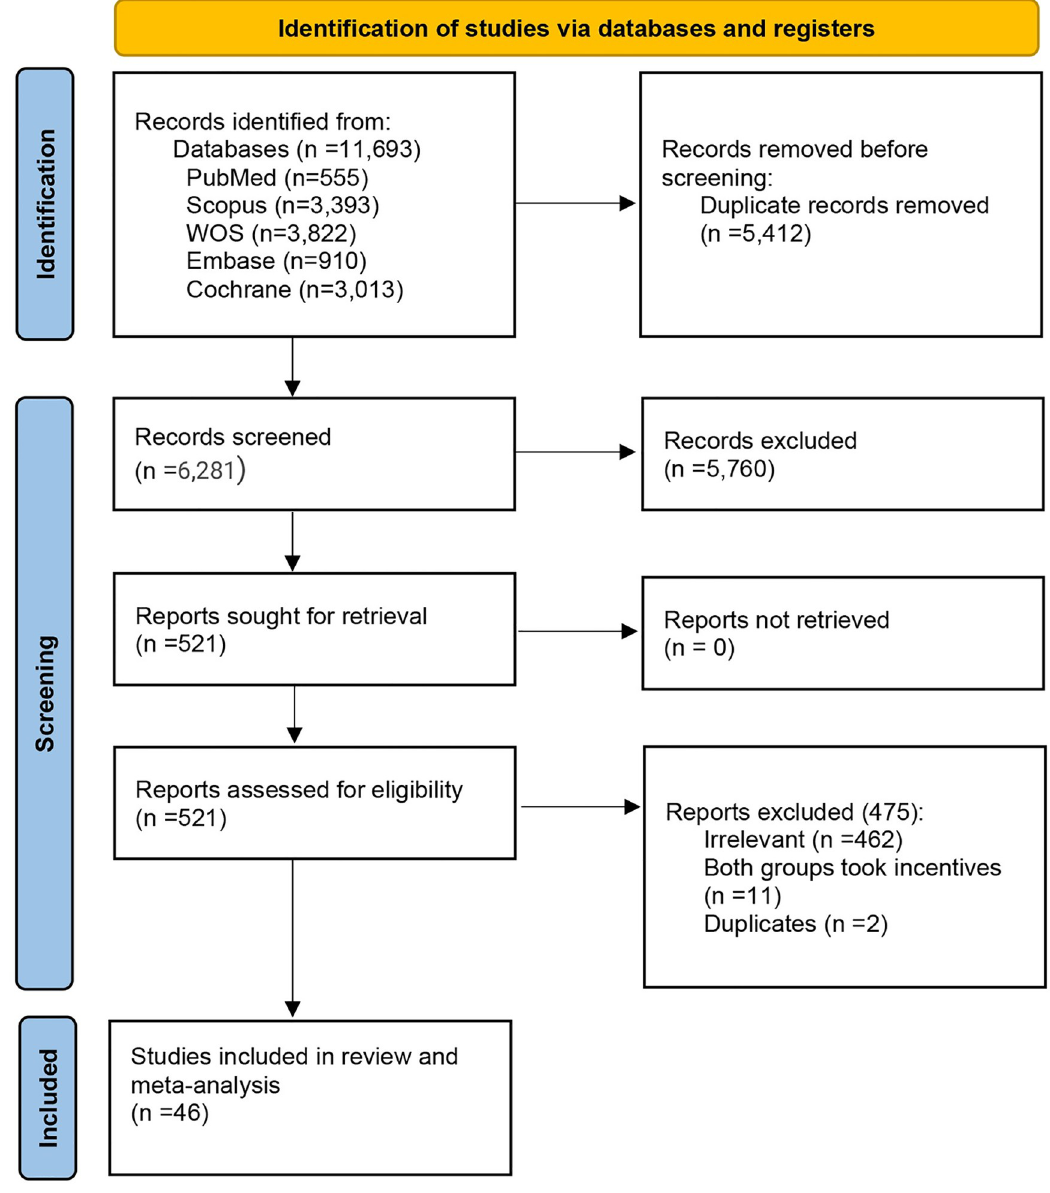
Fig 1. PRISMA 2020 flow diagram for systematic reviews, which included searches of databases, registers, and other sources.